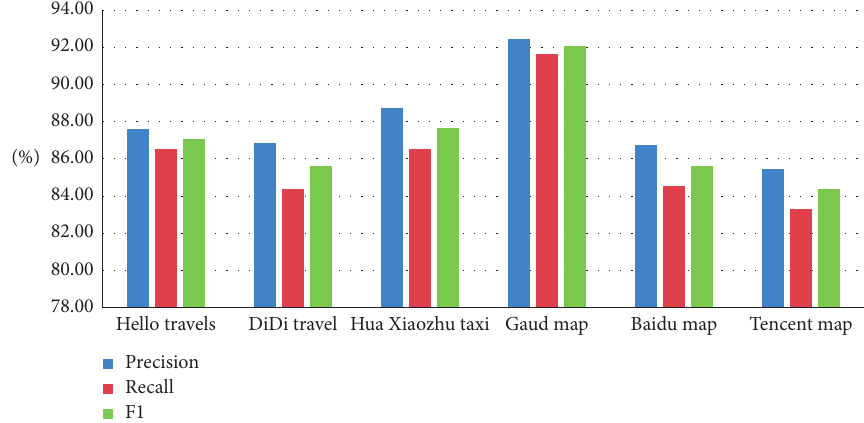
Figure 16: Comparison of transportation recommendation performance of tourism platform.